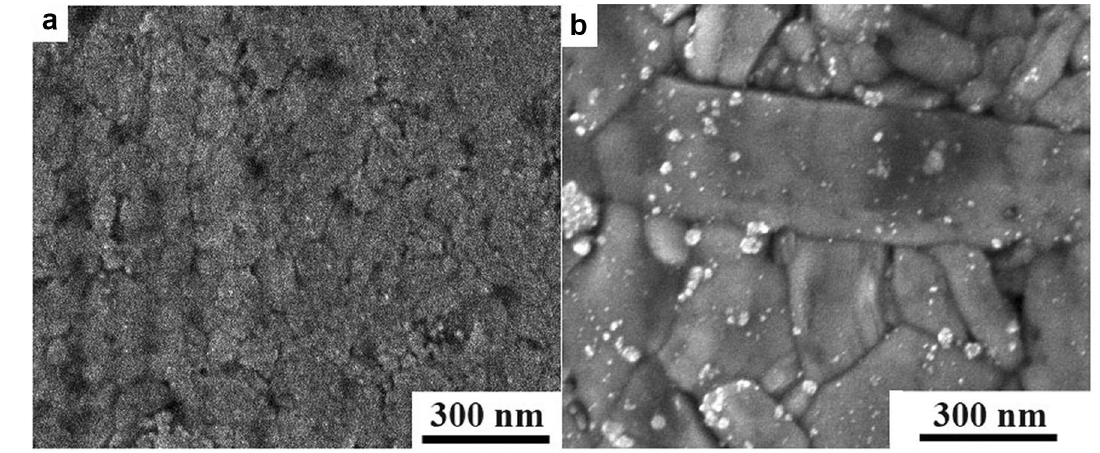
Fig. 4 SEM images of the surface of a semiconductor material before ( a ) and after doubly PT ( b )